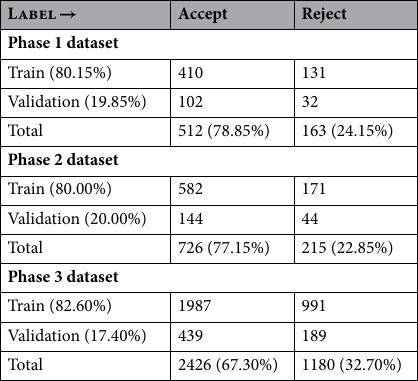
Table 4. Details of the gradual datasets used to evaluate the performance of the CNN models.